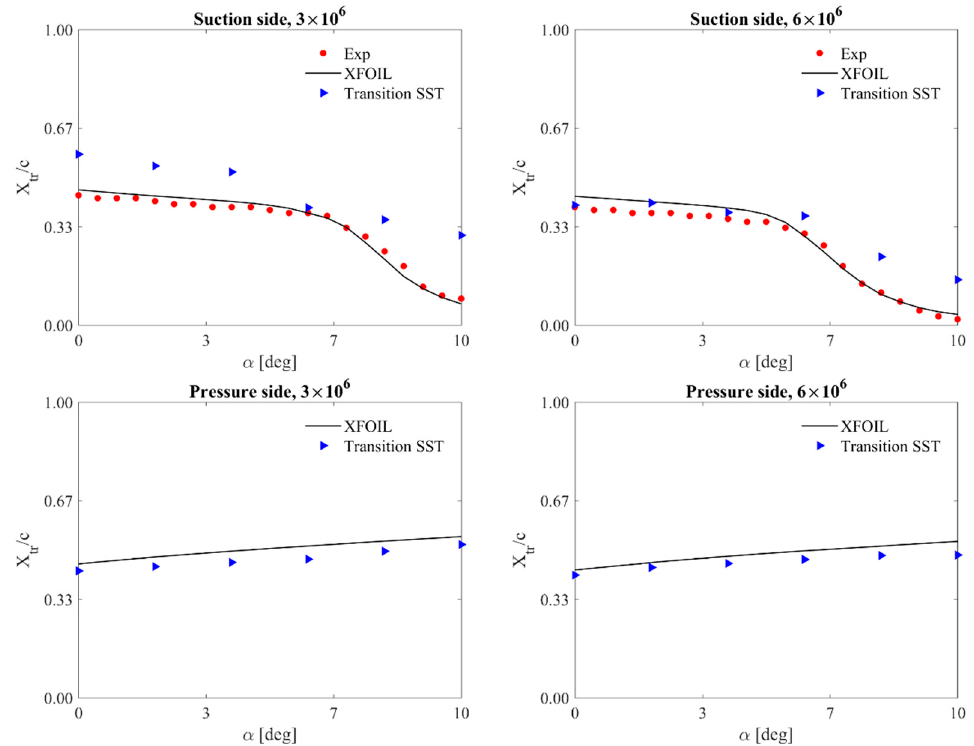
Figure 16. Variation of transition location with the angle of attack for two Reynolds numbers. For the suction side of the airfoil: validation of the Transition SST turbulence model and the XFOIL code using the experimental data; for the pressure side: comparison of the results obtained from CFD and XFOIL simulations.